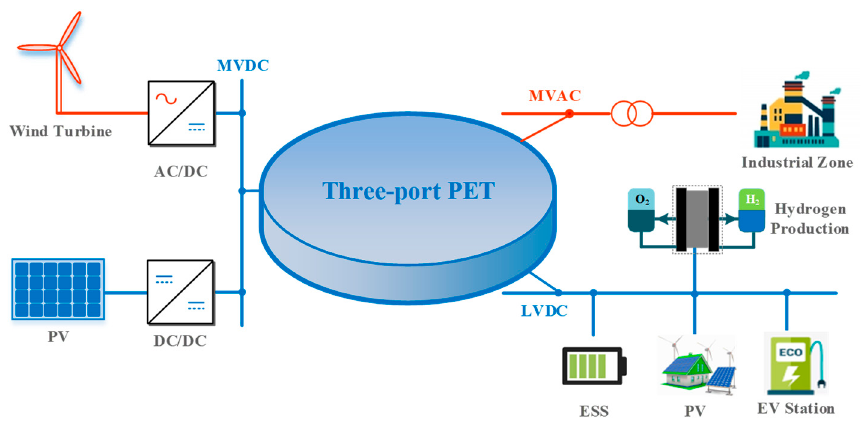
Figure 1. Application of the proposed three-port PET.